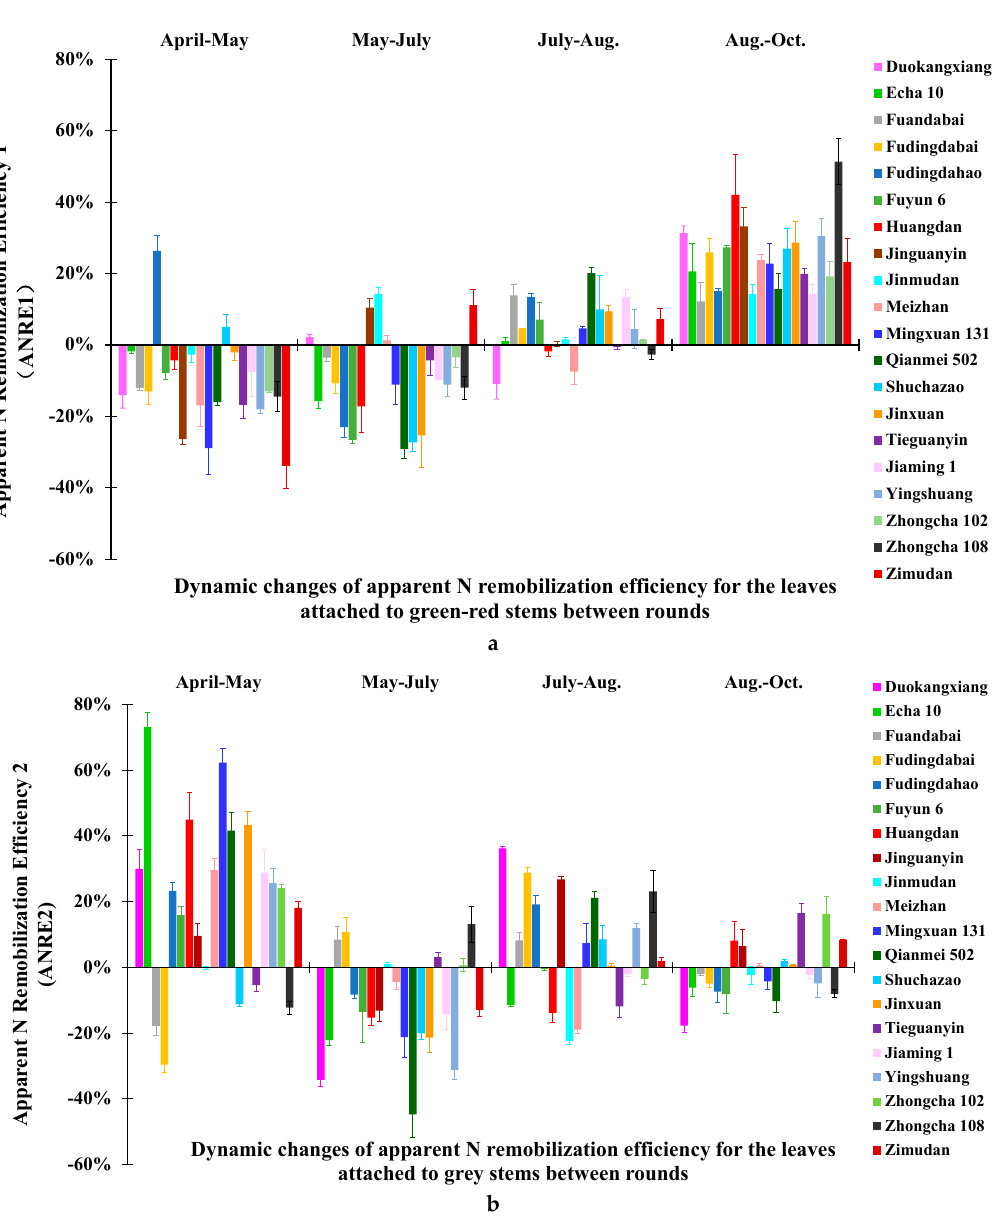
Figure 2. Dynamic changes of apparent N remobilization efficiency for leaves attached to green-red stems ( a ) and to grey stems ( b ) of the twenty tea plant varieties during the growing seasons. Values are means ± standard (SD) ( n = 3). Error bars indicate SD.